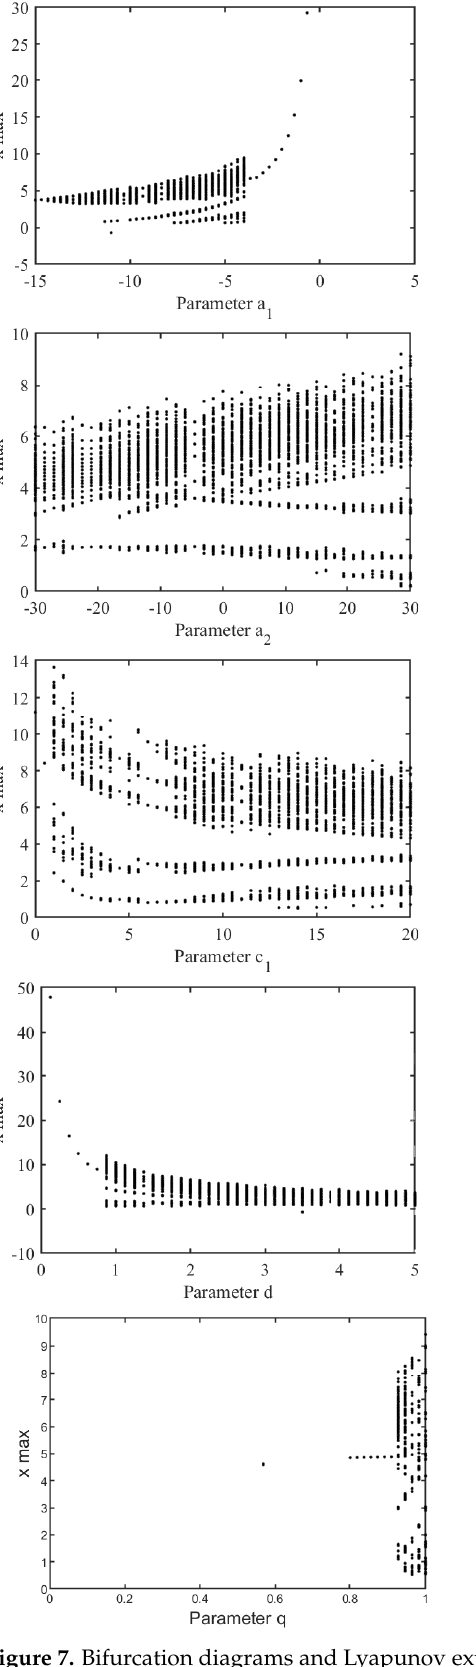
Figure 7. Bifurcation diagrams and Lyapunov exponents spectra of the optimized fractional-order system (2), using parameters a 1 , a 2 , c 1 , d and fractional-order q , for the PSO-optimized